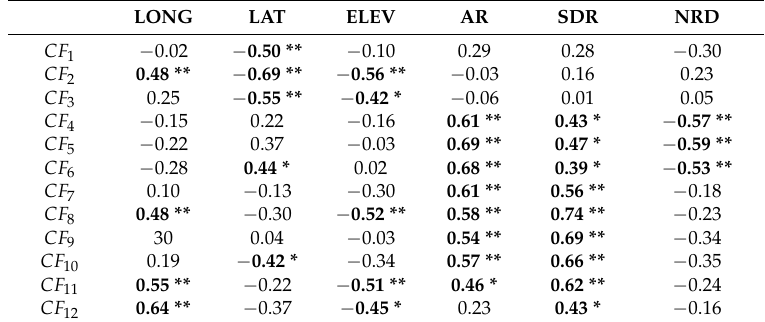
Table 6. Correlation coefficient between correction factors of TMPA 3B42RT against climatology– topography characteristics.